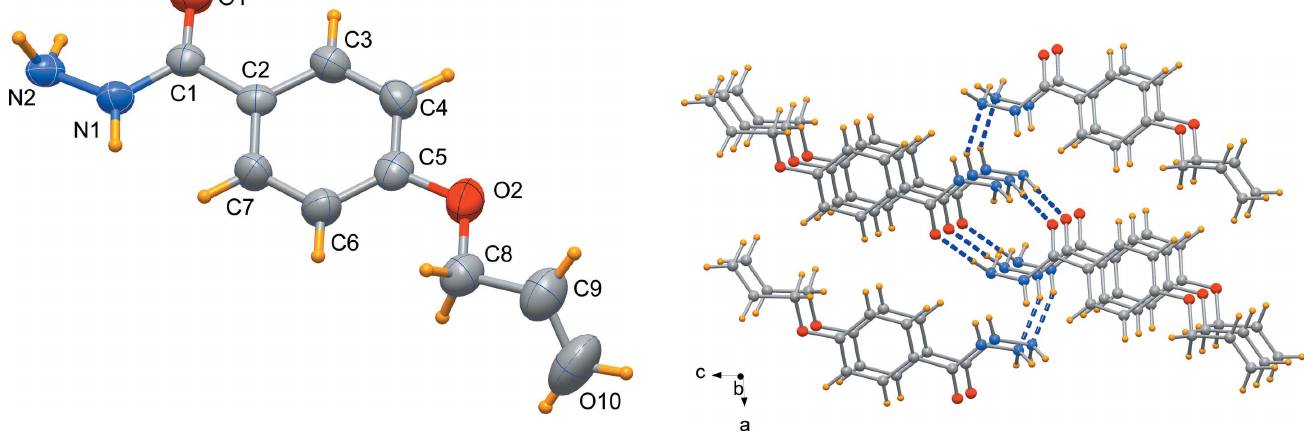
Figure 2 Detail of the crystal packing showing hydrogen-bonding interactions as blue dashed